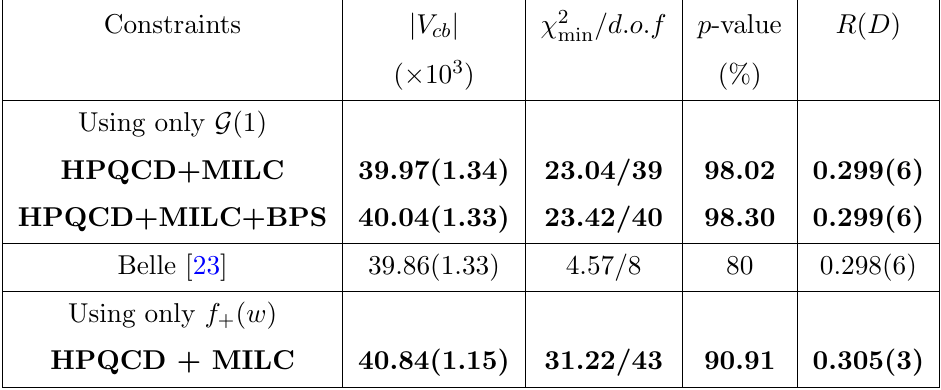
Table 3 . Result of the (cid:12)t to the experimental data in B ! D‘(cid:23) ‘ using only G (1) ((cid:12)rst two rows), and using f + ( w ) ( w = 1 and w 6 = 1) from lattice (MILC and HPQCD listed in table 1) with the CLN parametrization of the form